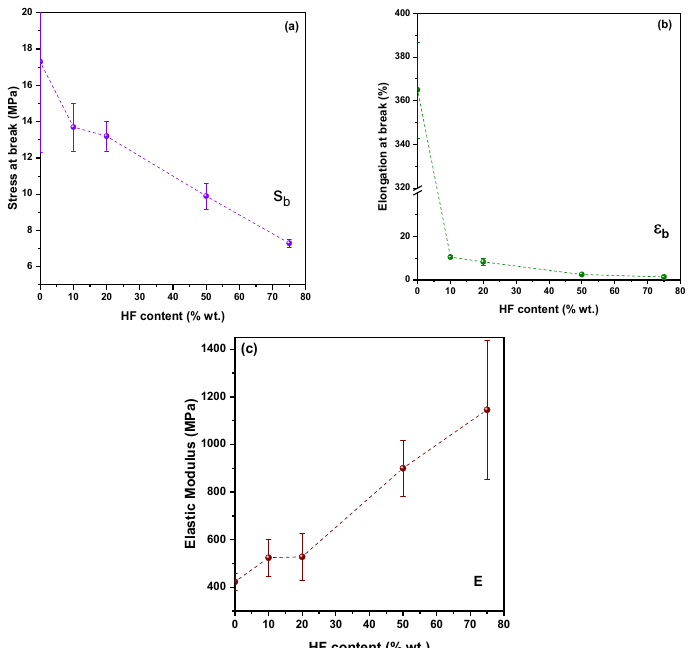
Figure 12. Effect of HF content on the ( a ) tensile stress at break, ( b ) elongation at break, and ( c ) elastic modulus of recycled high-density polyethylene (r-HDPE) + hemp fibers (HF) + Joncryl (JC) composite materials. The lines are drawn to guide the eye.